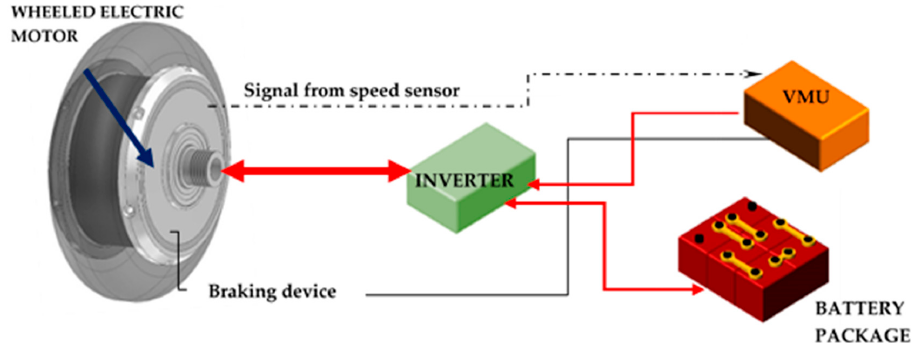
Figure 6. Example of a Regenerative Braking Control Strategy for In-wheel Electric Motors (Only One Wheel is Considered).